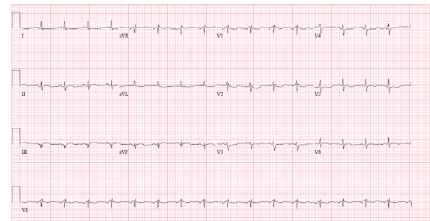
Figure 7: Resolution of ST elevation after surgical intervention (case